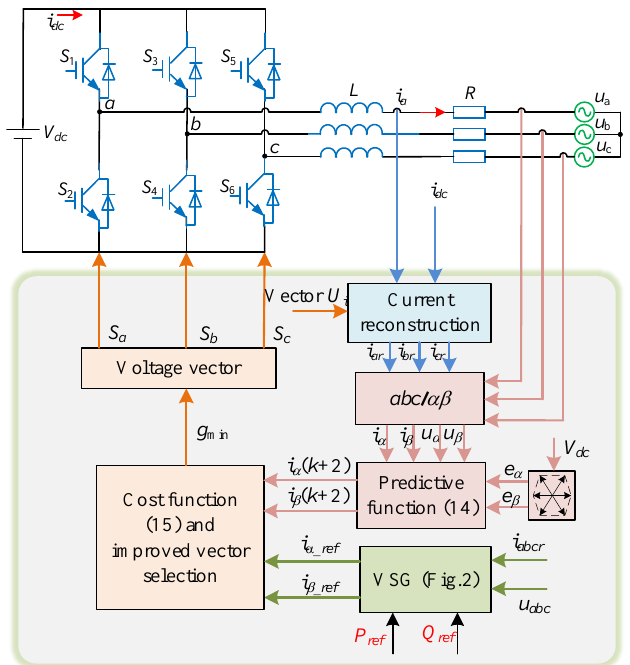
Figure 8. The control structure of proposed MPC-VSG using reconstructed current and improved vector selection.